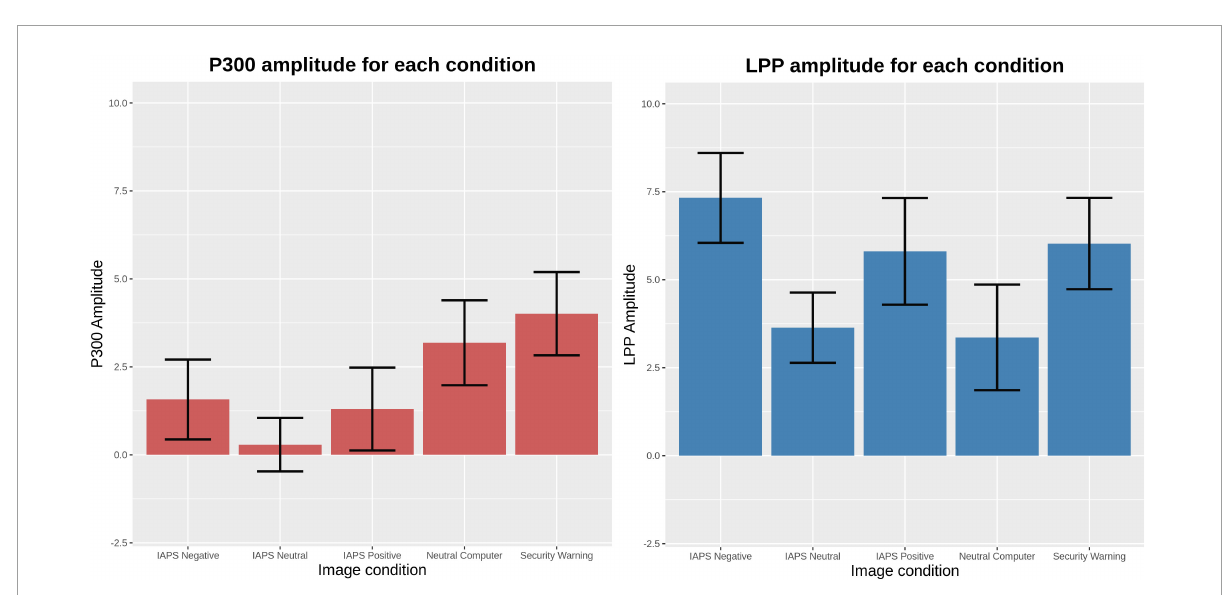
FIGURE3 Comparisons of event-related potential mean amplitudes with 95% confidence intervals. These means were assessed using linear mixed